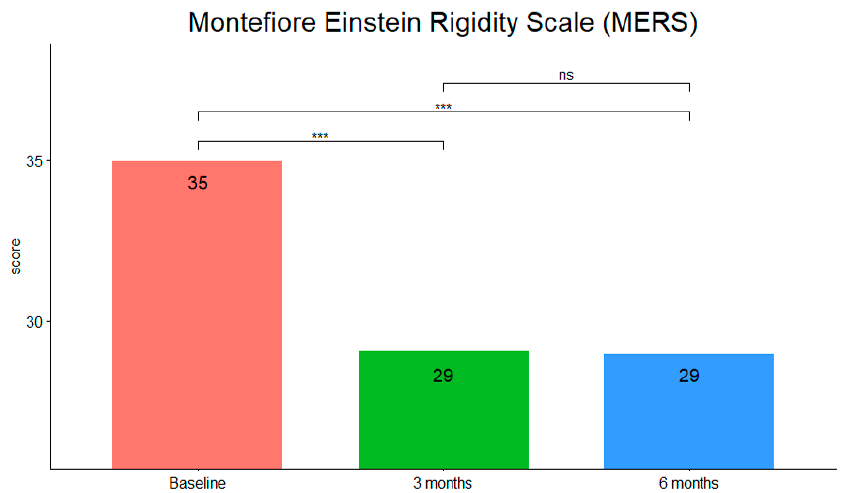
MERS score from pre-intervention to three months ( p < 0.001) and from pre-intervention to six months ( p < 0.001) but not from three to six months ( p > 0.05).